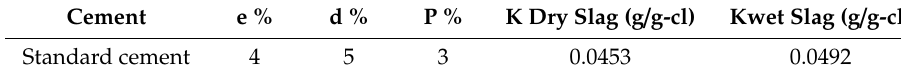
Table 11. Consumption quota of slag.